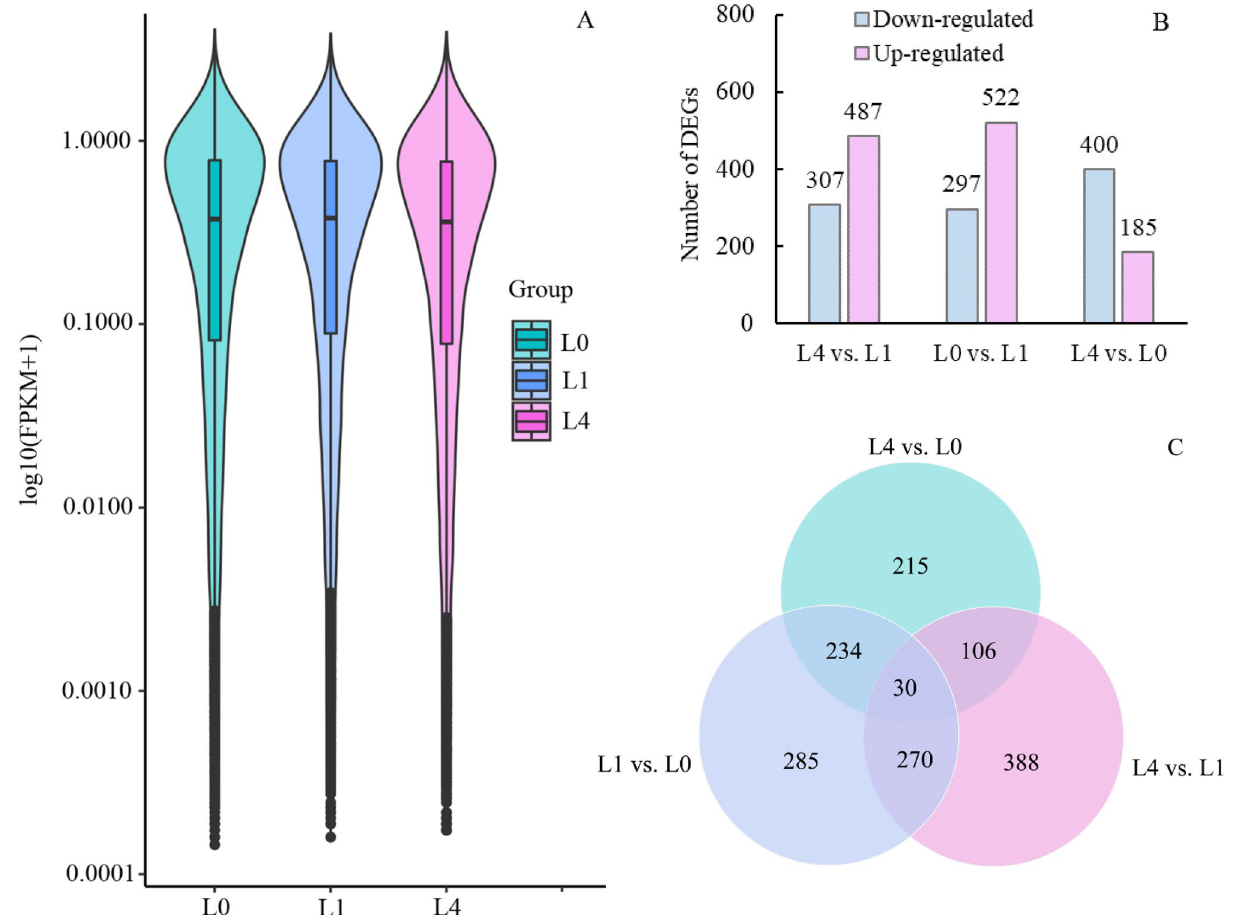
Figure 3. The distribution diagram of gene expression level in L0, L1 and L4 group ( A ), number of DEGs ( B ) and Venn diagram analysis of DEGs ( C ) in the L4 vs. L1, L0 vs. L1, and L4 vs. L0 RNA sequencing and reference genome alignment. In total, 41.7 Gb of clean reads were obtained, with an average of 4.6 Gb per sample. The Q20 value for the clean reads was > 98%, and the Q30 value was > 94% (Table S1), indicating the high-quality sequencing results for subsequent analysis. On average, 87.6% of reads were mapped, and the uniformity of the mapping result for each sample suggested they were comparable. The mapping results are shown in Table S2. Identification and annotation of differentially expressed genes (DEGs). DEGs were identified by comparing gene expression among 0(L0), 1(L1) and 4(L4) mM. The expression levels were similar in the three treatments were similar, and the log10 (fragments per kilobase per million (FPKM) + 1) values were mainly con- centrated around 1(Fig. 3A). In total, 794 DEGs were identified in the comparison L4 vs. L1, with 487 DEGs up- regulated and 307 DEGs down-regulated. Eight hundred twenty-nine DEGs were identified in the comparison L0 vs. L1; of these, 522 DEGs were up-regulated and 297 DEGs were down-regulated. Five hundred eighty-five DEGs were identified in the comparison L4 vs. L0, with 185 DEGs up-regulated and 400 DEGs down-regulated (Fig. 3B). Among all three comparisons above, the total number of down-regulated genes was higher than that of up-regulated genes. Additionally, most DEGs were identified in the L0 vs. L1 comparison group. Only 30 DEGs were identified simultaneously in the three comparisons (Fig. 3C). The DEGs significantly associated with enriched Gene Ontology (GO) terms and shared by the three com- parisons were listed in Fig. 4. The results of GO enrichment analysis showed 21 significantly enriched (false dis- crimination rate (FDR) ≤ 0.05) GO terms for the L0 vs. L1 comparison and 29 significantly enriched (FDR ≤ 0.05) GO terms for the L4 vs. L0 comparison. For the L0 vs. L1 and L4 vs. L0 comparisons, response to stimulus and cell wall were the top enriched terms in the biological process and cellular component category, respectively. In the molecular function category, oxidoreductase activity was the top enriched term for the L0 vs. L1 comparison, whereas nucleic acid binding transcription factor activity was the top enriched term for the L4 vs. L0 comparison. However, for the L4 vs. L1 comparison, there was no significantly enriched GO term. Furthermore, we independently analyzed DEGs in the three Al treatment concentrations to assess whether they were enriched for genes that regulate metabolic pathways (Fig. 5).The DEGs in the L1 vs. L0 comparison were significantly enriched(FDR < 0.05) in 31 pathways. Transporters was the most dominant pathway, followed